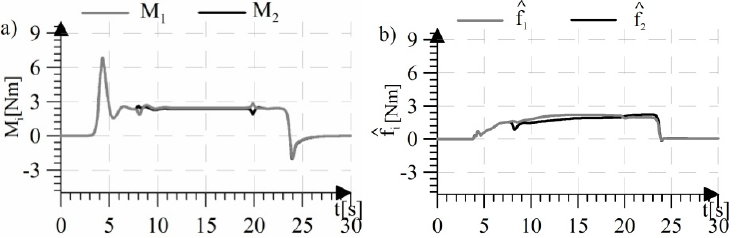
Figure 2: Total control and compensation signals received during the learning of conclusions and conditions of the neuro-fuzzy rule base.